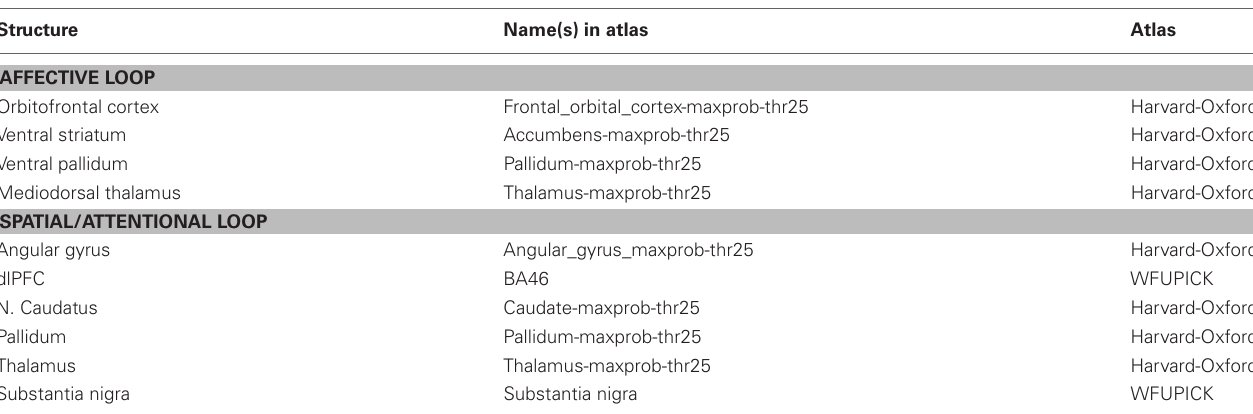
Table A1 | Overview over all ROI used in this